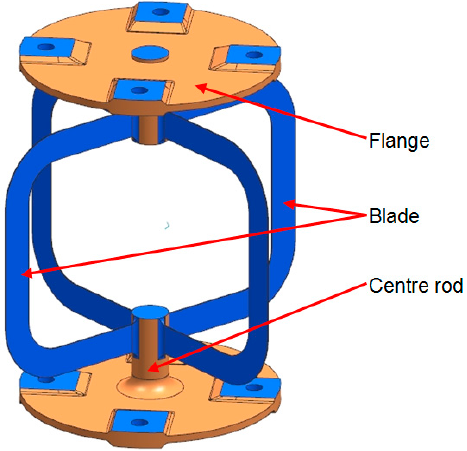
Figure 22. AM flexible pivot with functional elements (postprocessed surfaces are highlighted blue).